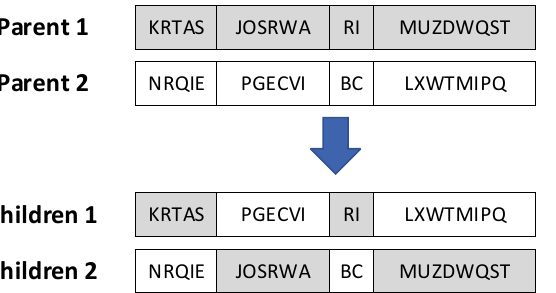
Figure 2. Crossover.